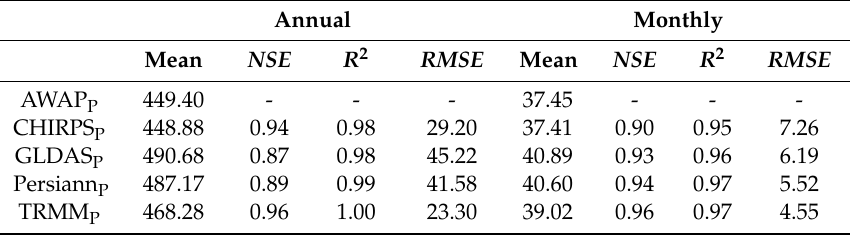
Table 3. Comparison statistics of global precipitation data products against AWAP precipitation at the basin